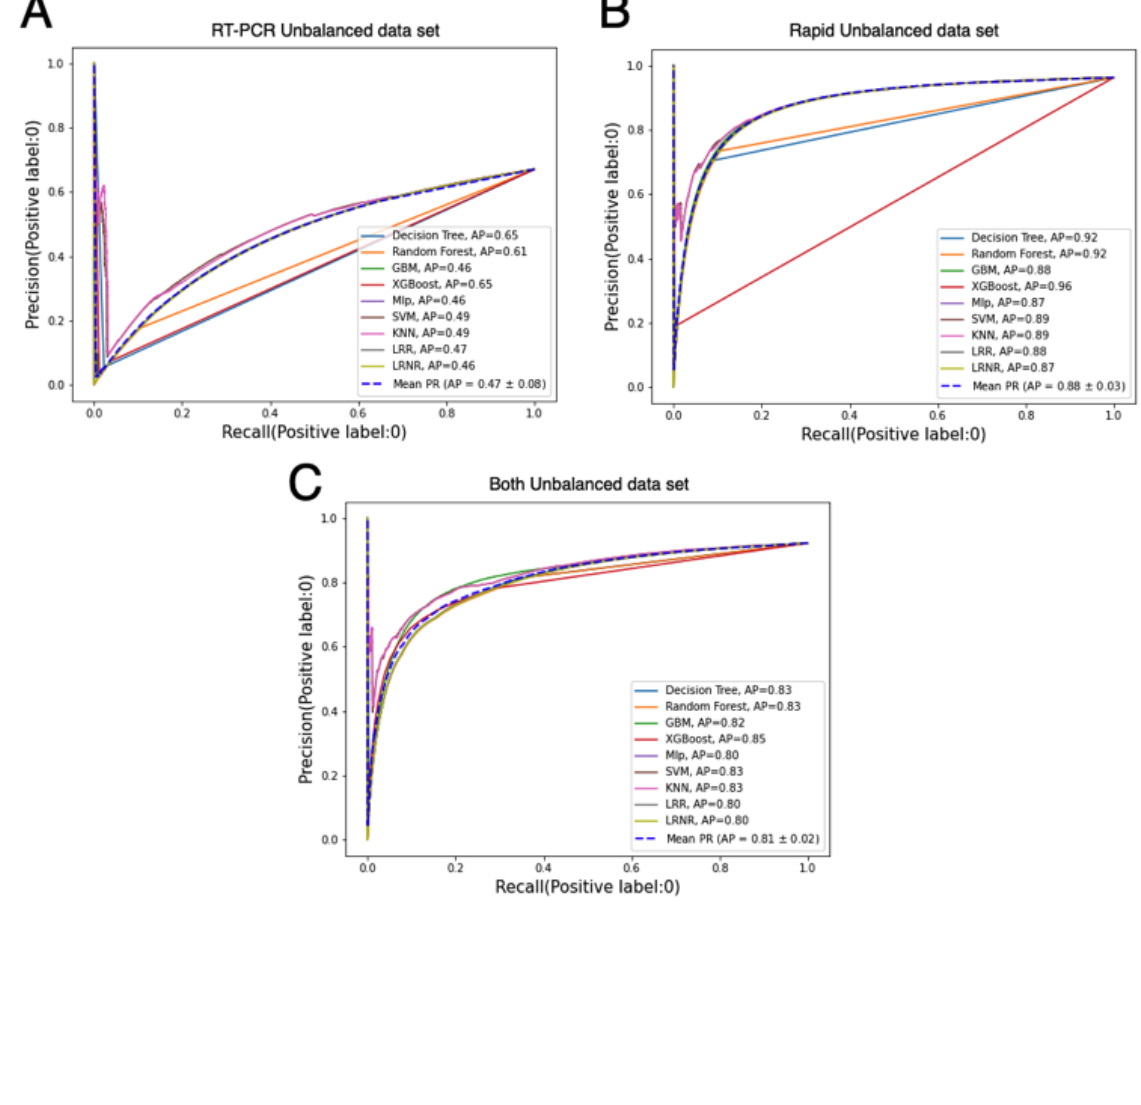
Figure 5. Models' precision-recall curve with (A) RT-PCR unbalanced data set, (B) rapid unbalanced data set, and (C) both unbalanced data set. AP: average precision; GBM: gradient boosting machine; KNN: k-nearest neighbors; LR: logistic regression (weak regularization); LRR: logistic regression (strong regularization); Mlp: multilayer perceptron; PR: precision-recall; RT-PCR: reverse transcription polymerase chain reaction; SVM: support vector machine; XGBoost: extreme gradient